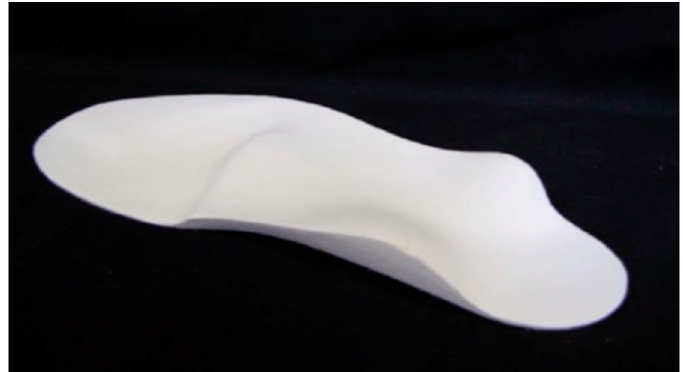
Figure 1. Sensorimotor orthosis [24].